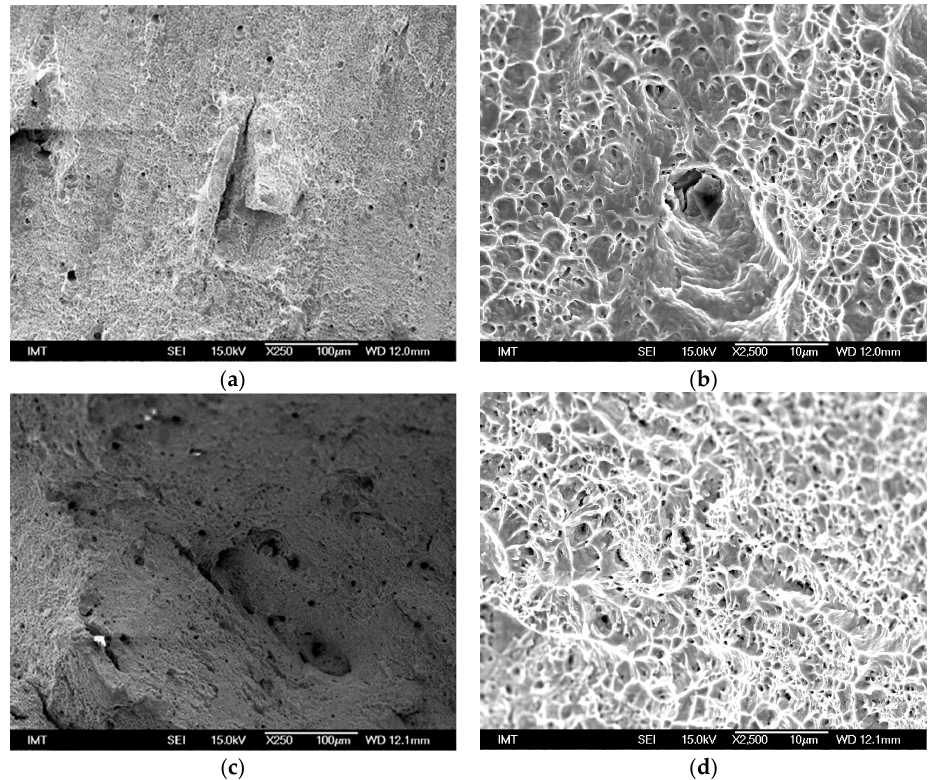
Figure 18. The Fracture surfaces of the samples hot rolled at 1050 °C with the deformation level of 23.5% (unaged) ( a,b ) and aged at 750 °C for 5 h ( c,d ).